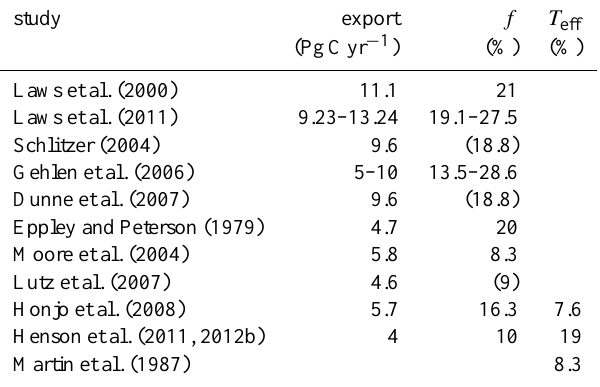
Table 5. Global annual export and global mean export ratios and transfer efficiencies from other studies in the literature. The trans- fer efficiency for Martin et al. (1987) was estimated using an export depth equal to the global mean for CCSM–BEC (T eff = (cid:16) 2000 (cid:17) − 0 . 858 ) . The Laws et al. (2000) estimate is for total 100 110 . 4 export (POC + DOC). The export ratios ( f ) between parentheses were estimated from global POC exports assuming global NPP of 51PgCyr − 1 (Carr et al.,